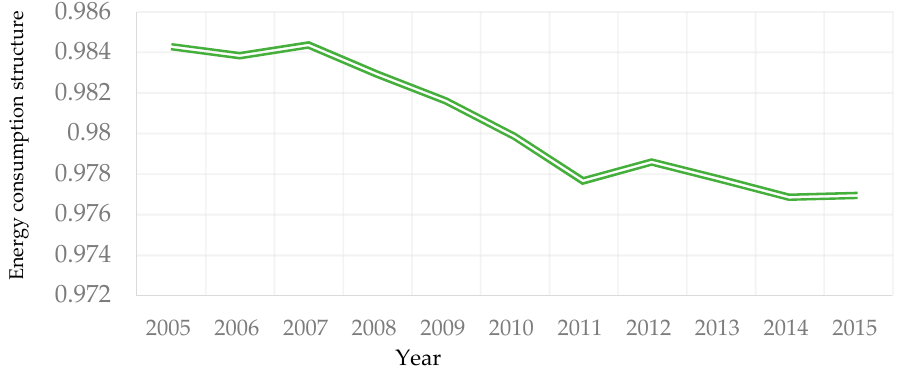
Figure 6. Changing trend of the BRI national transportation industry energy consumption structure from 2005 to 2015.